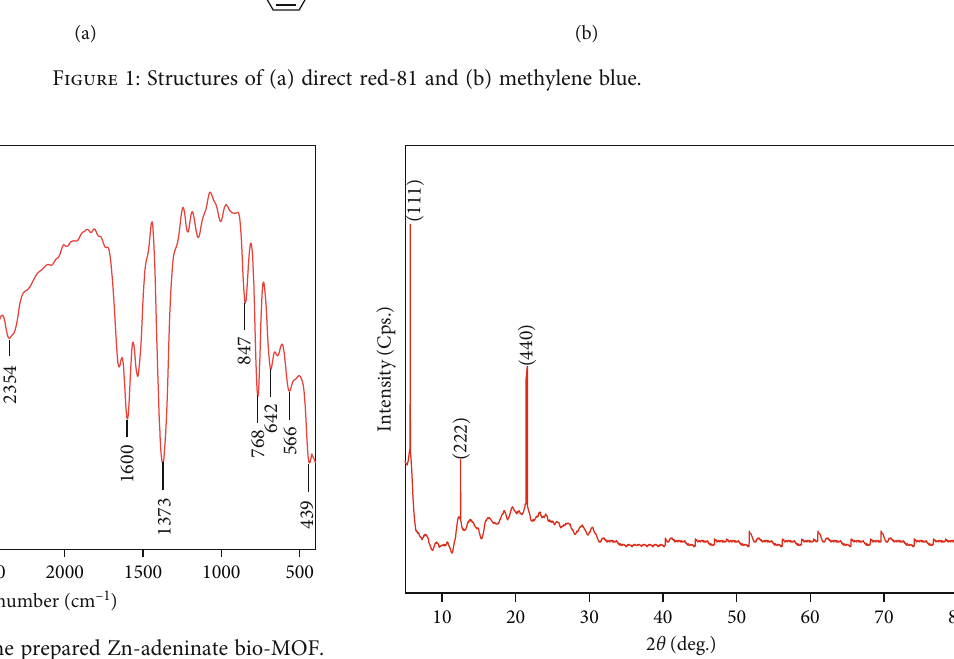
Figure 3: XRD pattern of the synthesized Zn-adeninate bio-MOF.